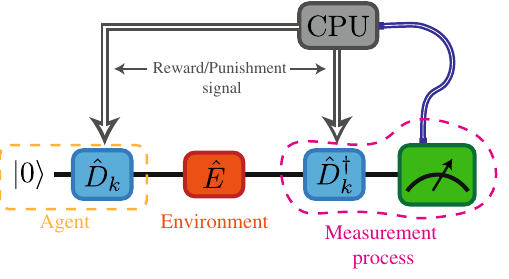
Figure 1. Diagram of the single-qubit protocol. The subindex k refers to the k th iteration. Blue lines represent the classical communication to the central processing unit. The gray arrows show feedback loops, where D † k are updated according to the measurement outcome.